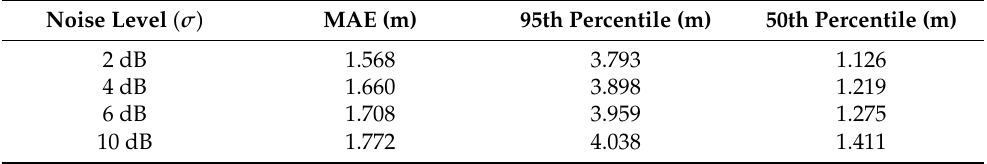
Table 2. Performance of the MLP-mmWP method with different levels of noise.